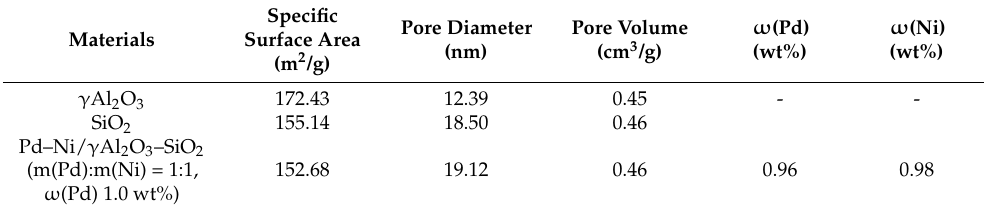
Table 4. Physico-chemical properties of carriers and Pd–Ni/ γ Al 2 O 3 –SiO 2